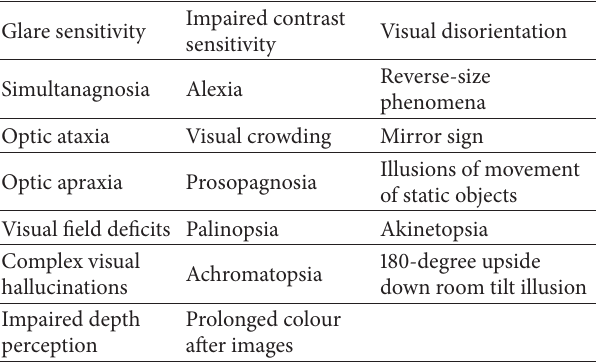
Table 1: Visual manifestations of posterior cortical atrophy